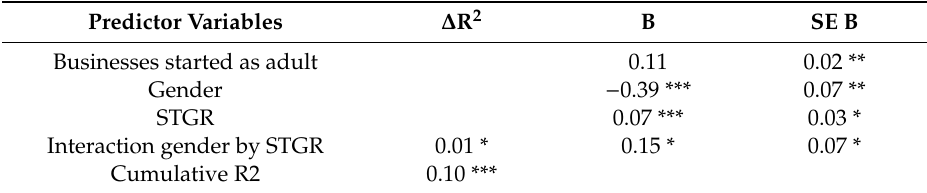
Table 4. Results of regression predicting EINT based on gender and support of gender roles.